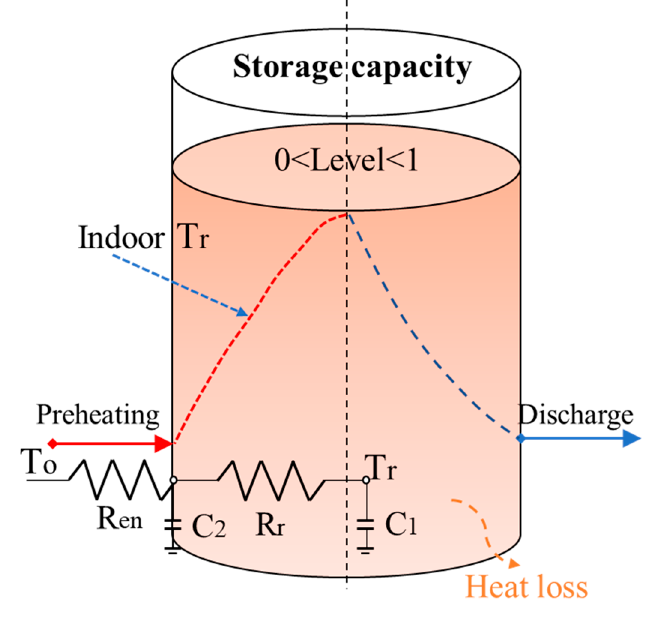
Figure 3. Energy node model of the virtual thermal energy storage system.